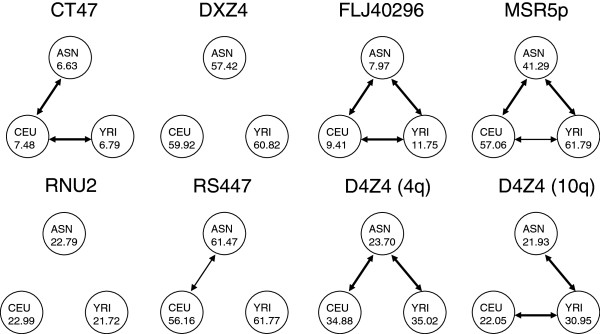
Results of genetic heterogeneity test by comparing the means of the populations. Genetic heterogeneity was investigated by cumulative distribution functions and mean repeat array size of the MSRs for each population. The results of the genetic heterogeneity test by comparing the means of the populations are illustrated for each MSR. The populations are depicted as a circle describing their mean repeat array sizes in number of repeat units. Dashed lines indicate a significant difference between populations (p-value < 0.05) and solid lines a p-value < 0.01. Both RNU2 and DXZ4 showed similar means of repeat array sizes in the different populations, while the means of the other six MSRs were significantly different for at least two populations. Genetic heterogeneity was variable for the MSRs, where it depended on the MSR which populations showed similar mean array sizes or significant differences.